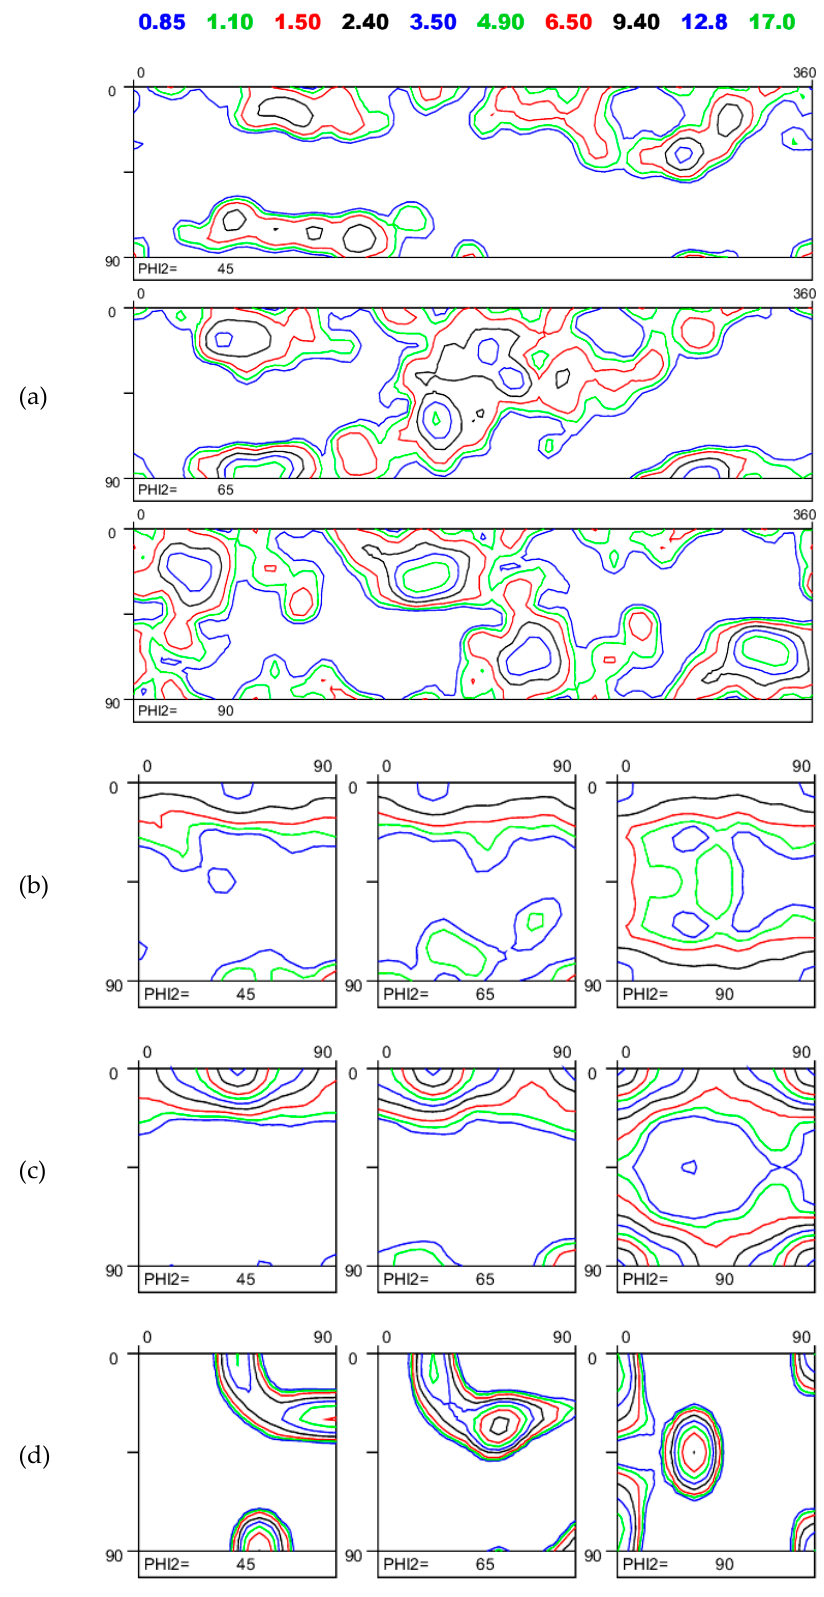
Figure 2. Hot band textures observed in the investigated materials: ( a ) material A, ODF max = 6.47, TI = 1.98; ( b ) material B, ODF max = 3.92, TI = 1.34; ( c ) material C, ODF max = 13.94, TI = 2.63; ( d ) material D, ODF max = 11.83, TI =